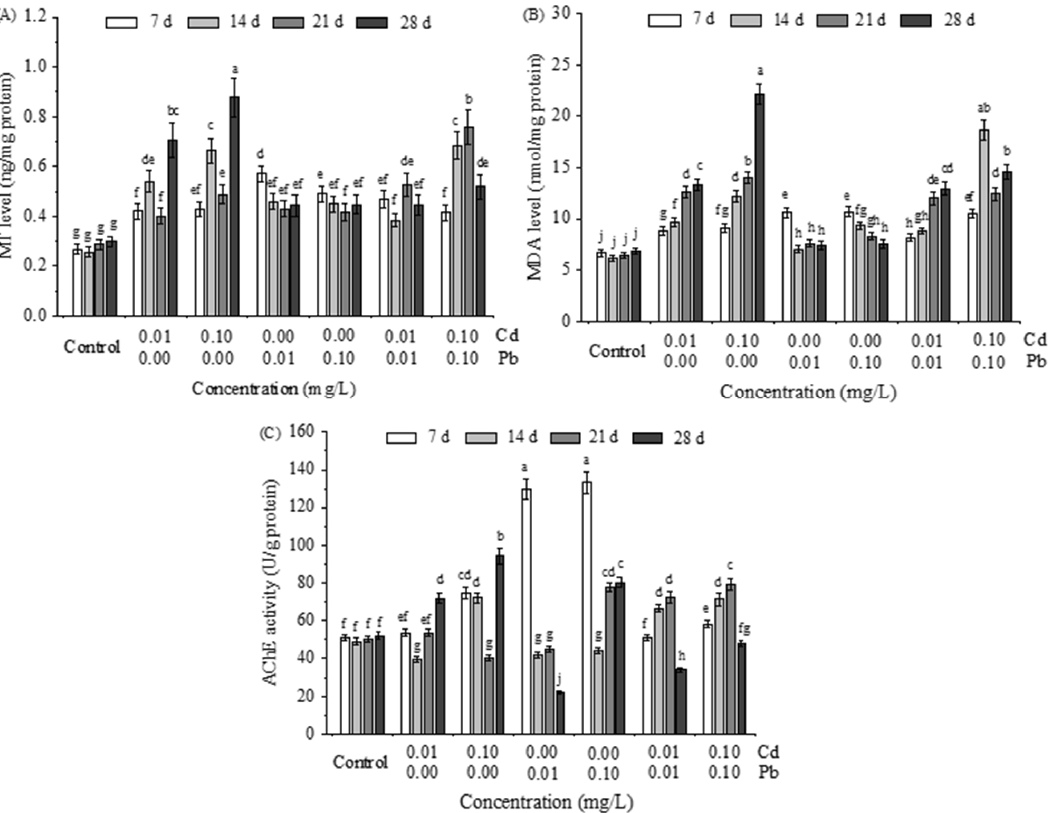
Figure 3. Changes of MT ( A ); MDA ( B ); and AChE ( C ) in the hepato of M. nipponense following various treatments with single Cd, Pb and their mixture along increasing concentrations (0.01 and 0.10 mg/L) at four time points (7, 14, 21 and 28 days). Different letters indicate a significant difference among groups (ANOVA, p < 0.05), while the same letters indicated no significant difference (ANOVA, p < 0.05). Control represents the water without Cd and